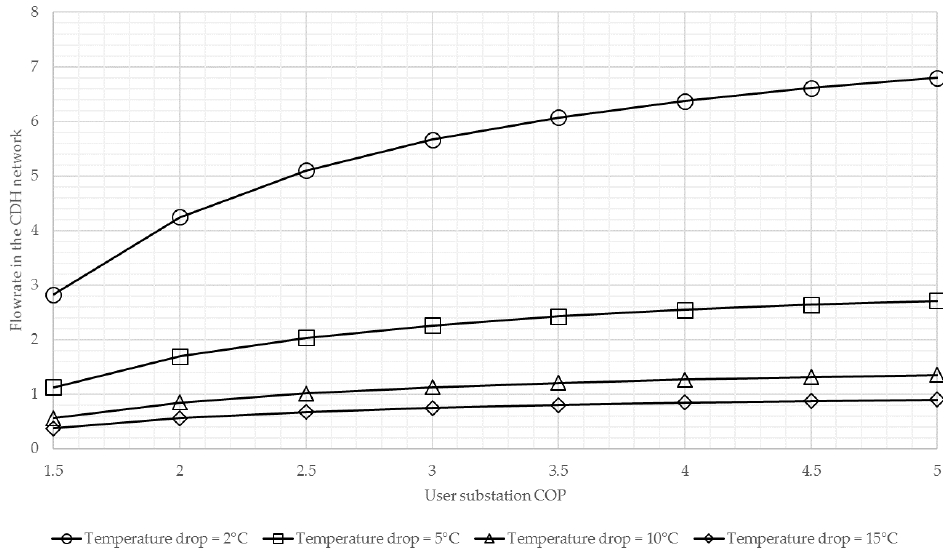
Figure 4. Flowrate network comparison between traditional district heating (equal to 1) and CDH as a function of available temperature drop in the CDH network and of heat pump coefficient of performance (COP) of the user substation.